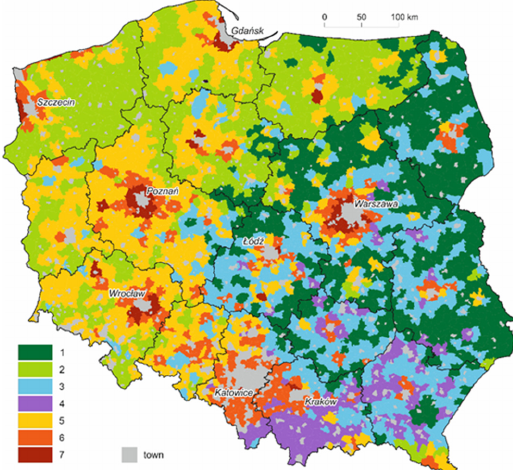
Figure 6. Village types according to the structure of socio-economic development components.